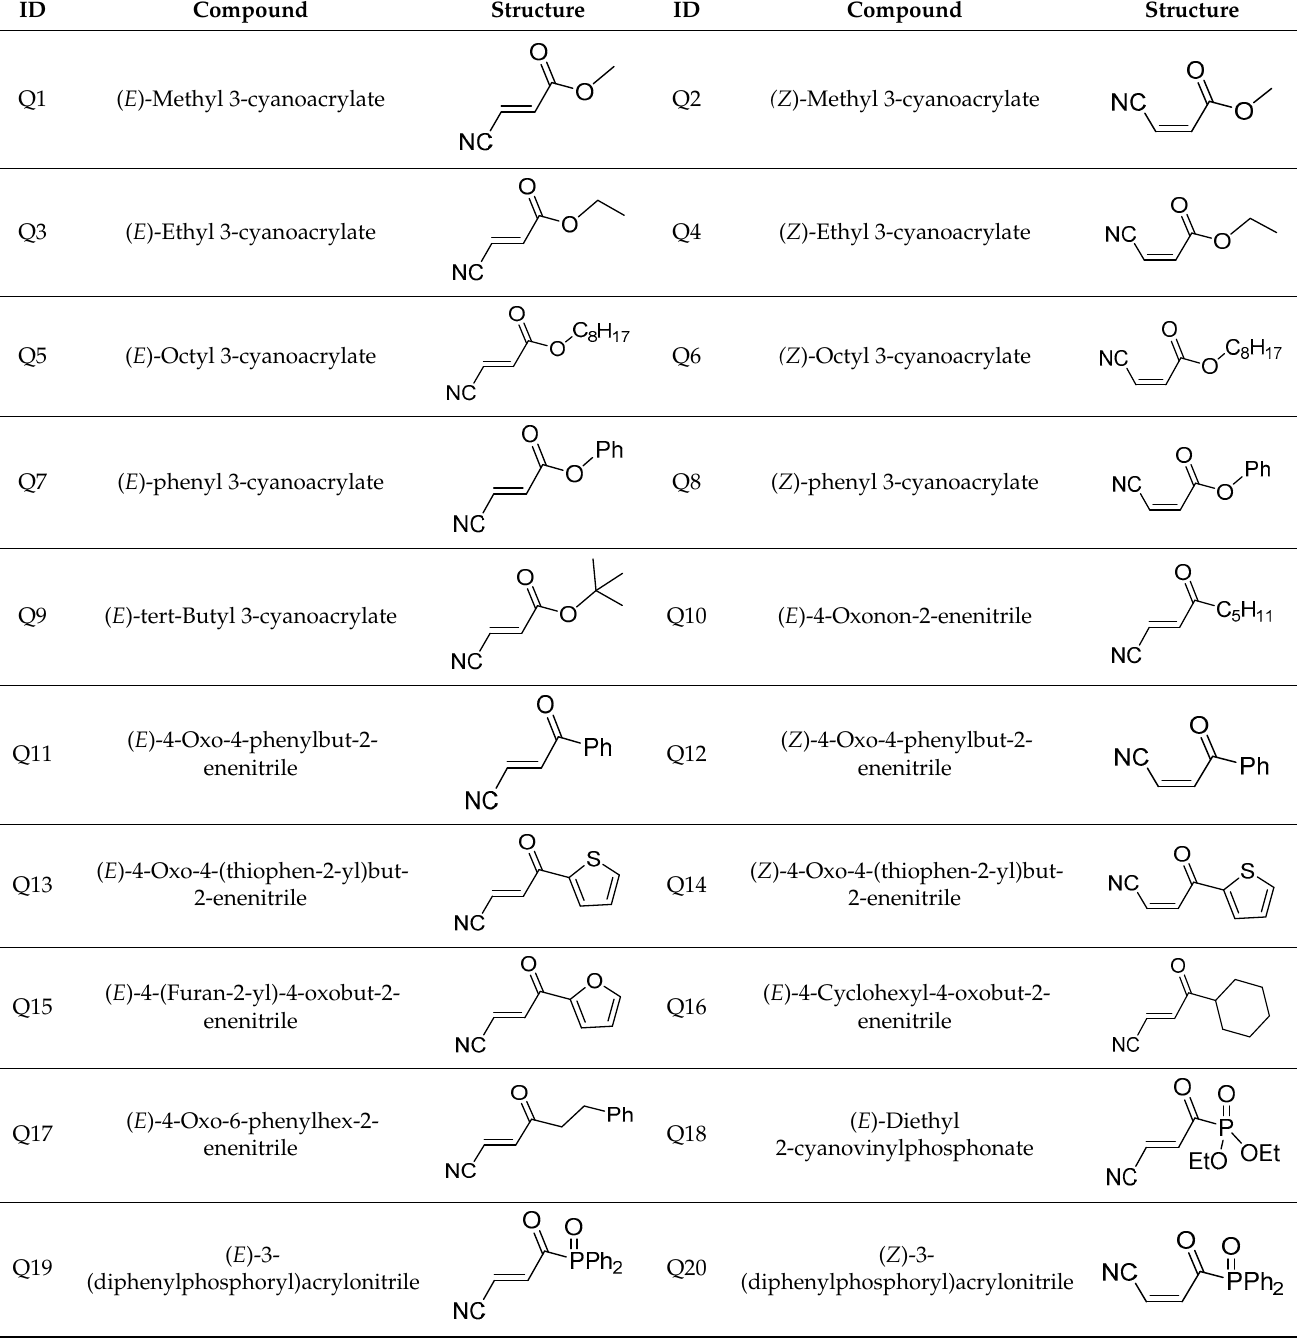
Table 4. Acrylonitriles included in this study and their molecular structure.